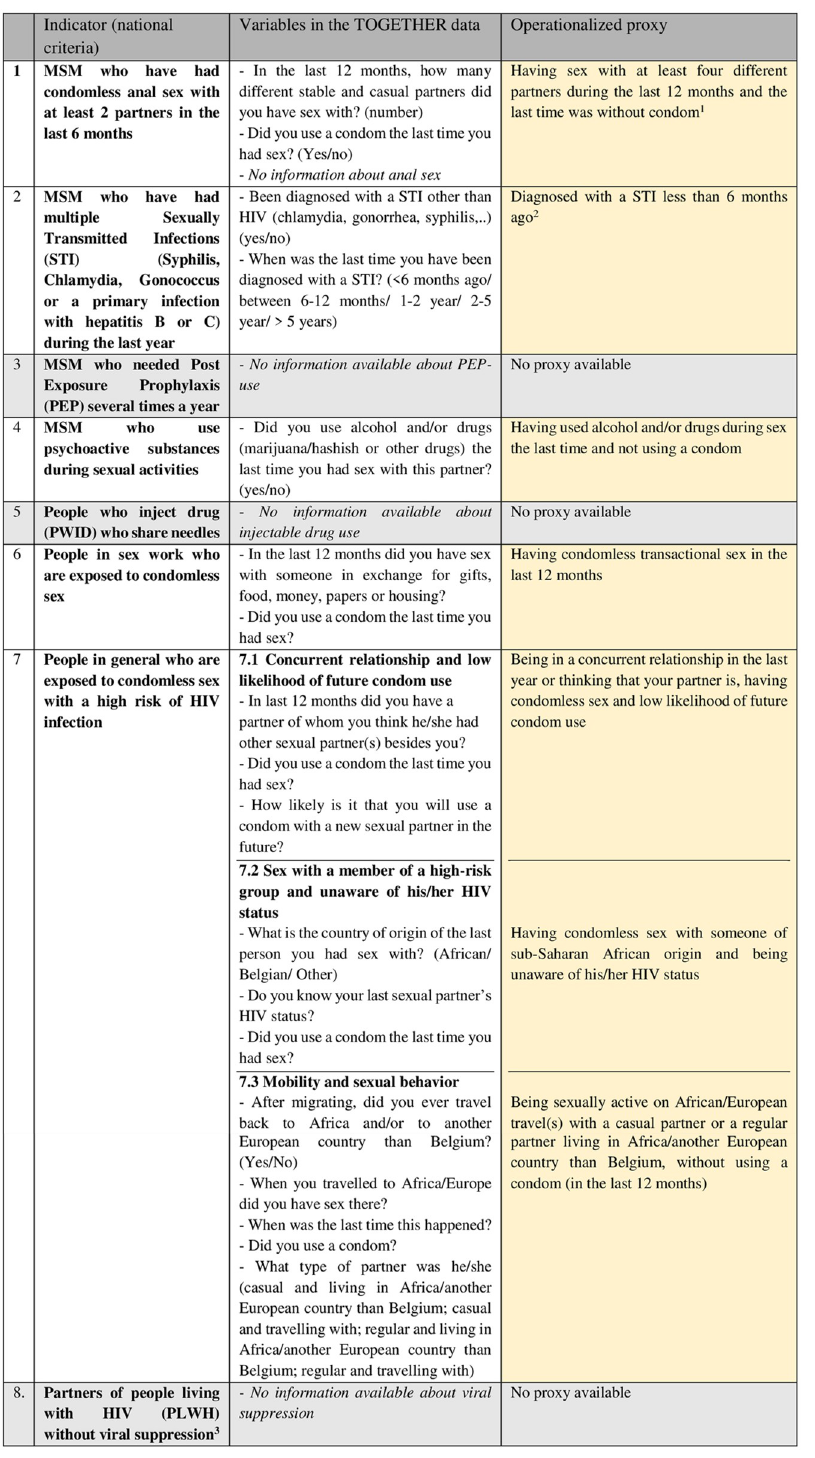
Fig 2. Box 2: The MSM specific and high-risk group eligibility criteria adjusted to SSA migrants and operationalized by the TOGETHER data. Notes: 1 We have doubled the number of sexual partners, as the period is doubled (the number of sexual partners was asked for the last 12 months instead of 6 months) and we do not have information about anal sex. 2 The guidelines consider the number of STIs during last year, while in the TOGETHER study participants only reported about lifetime STI and time of occurrence. Therefore, the time period from 12 months